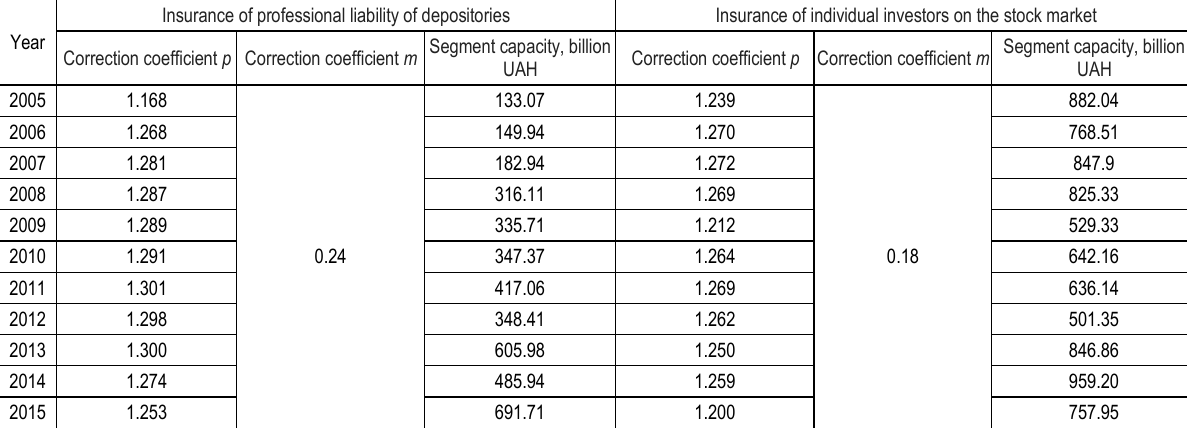
Table 5. Results of calculations of corrective coefficients and the capacity of the segments of insurance of professional liability of depositories and insurance of individual investors on the stock market in 2005 –